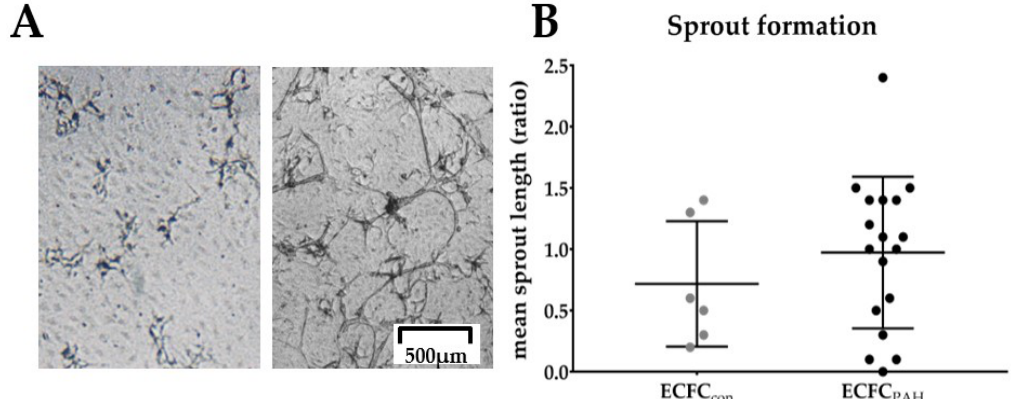
Figure 3. No difference in tube formation was observed among ECFC donors. ( A ) Representative phase contrast image of sprouts of PAH ECFC showing little or abundant tube formation. Scale bar indicates 500 μm. ( B ) Quantitative analysis of average tube length indicates no difference between control (grey, n = 6) or PAH ECFC (black, n = 18), normalized for mean tube length of control ECFC ( y -axis, ratio). Mean with standard deviation (SD) is shown.